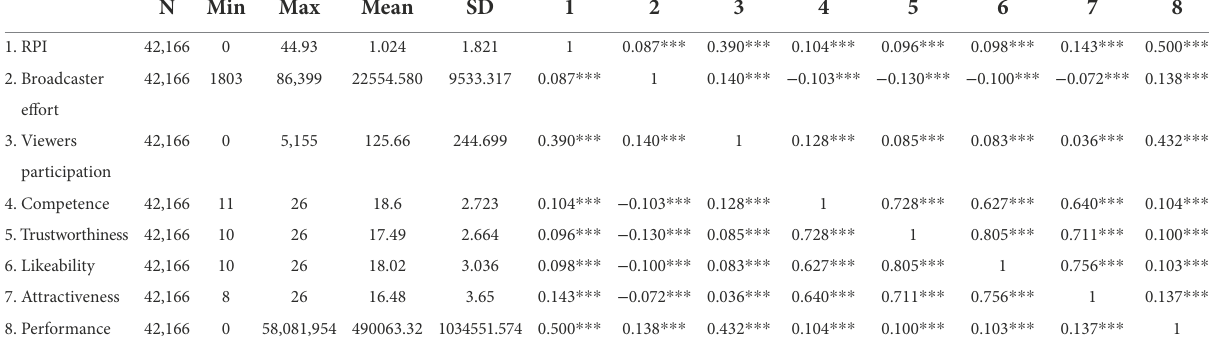
TABLE 1 Descriptive statistics and